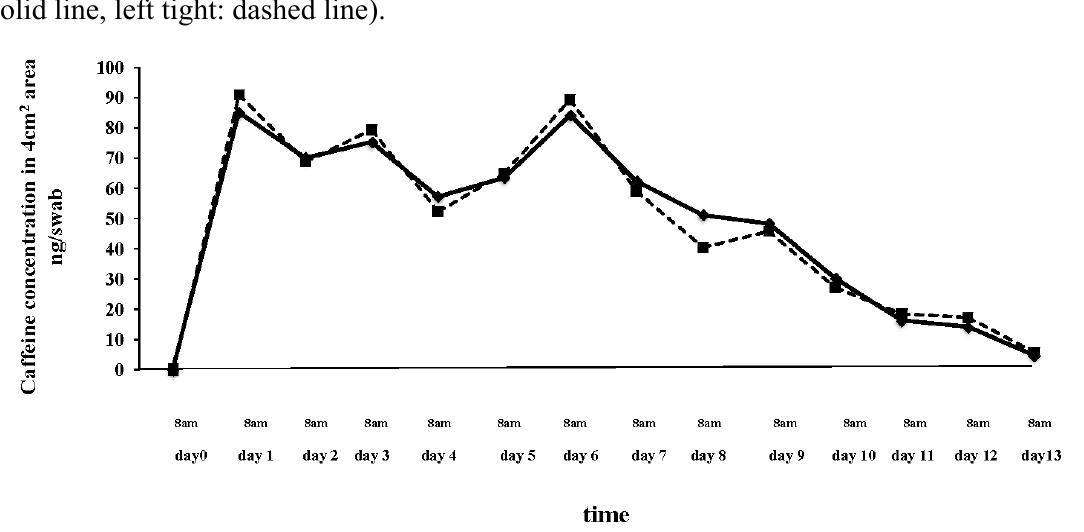
Figure 2. Time trend concentration of caffeine in the swabs used for rubbing the same 4 cm 2 section of skin of caffeine laced pants user during and after wearing (right thigh: solid line, left tight: dashed line).